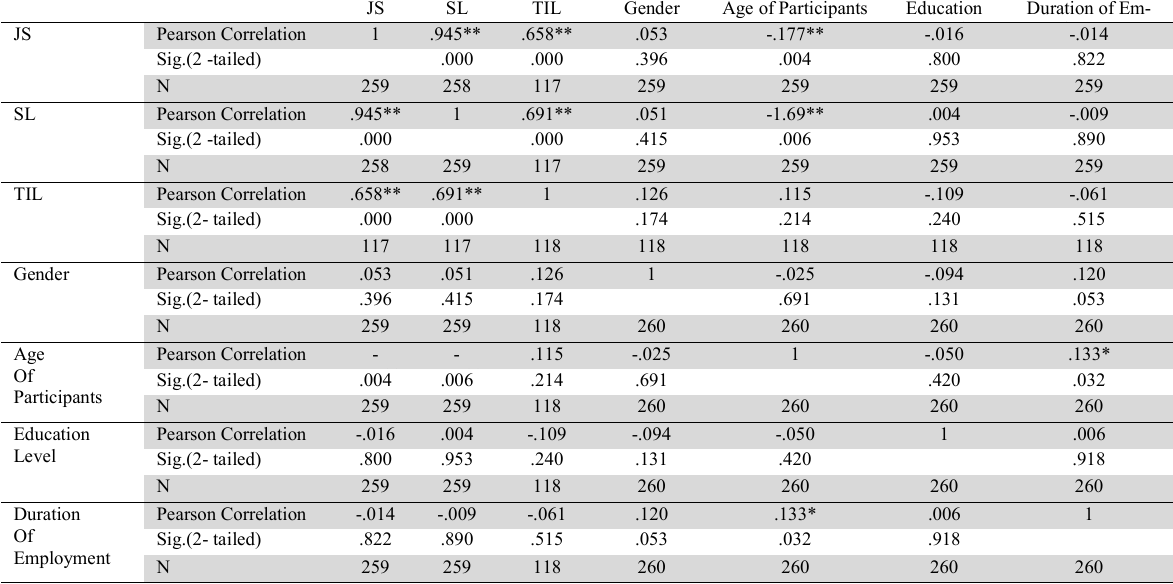
Correlation analysis of variables’